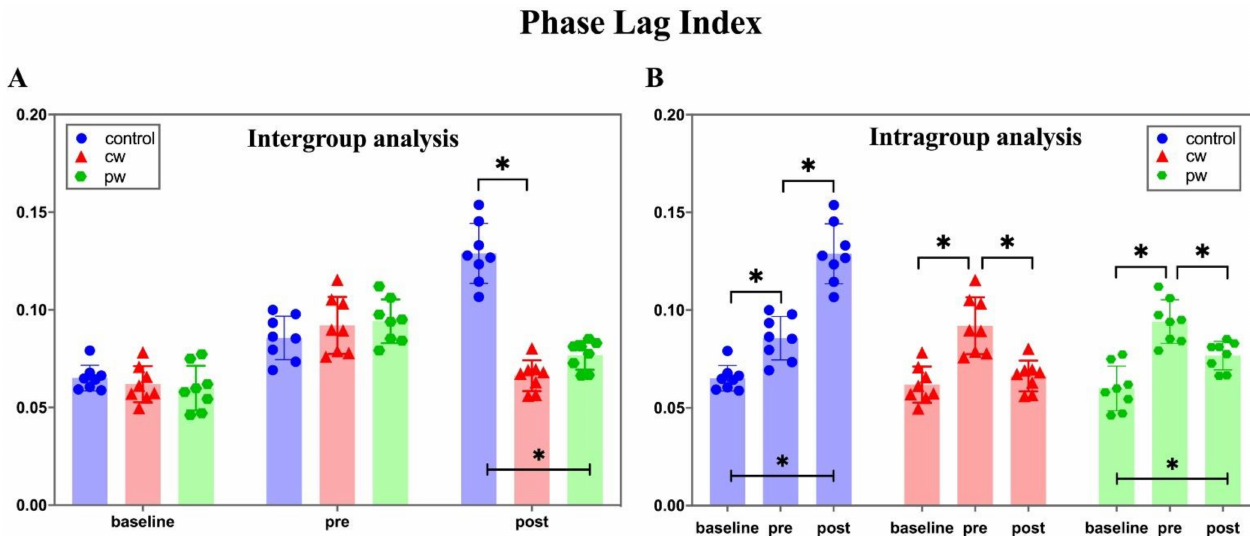
Figure 7. Mean phase lag index (PLI) for the broad-filtered band (0.1–48 Hz). ( A ) Intergroup analysis of the mean PLI at the different stages. ( B ) Intragroup analysis of the mean PLI in the three groups. * indicates significance ( p <